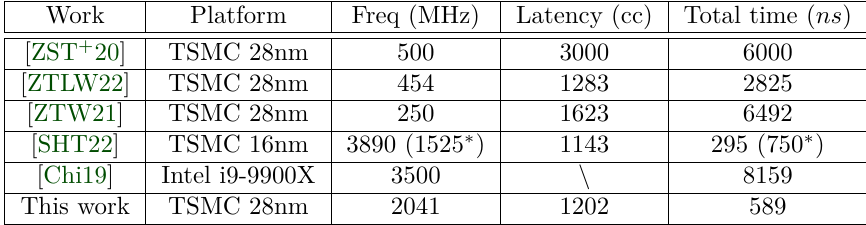
Table 8: Comparison to implementations of the